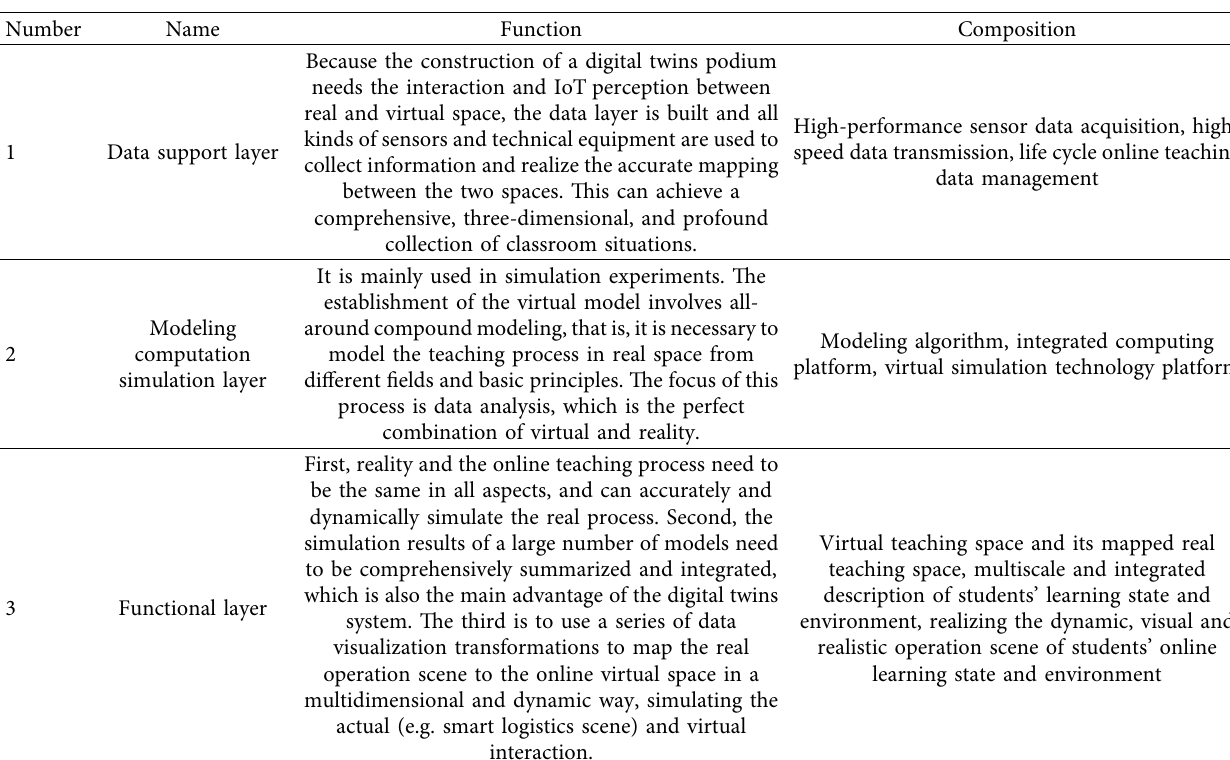
Figure 4: System of digital twins podium. Table 1: Hierarchy of digital twins